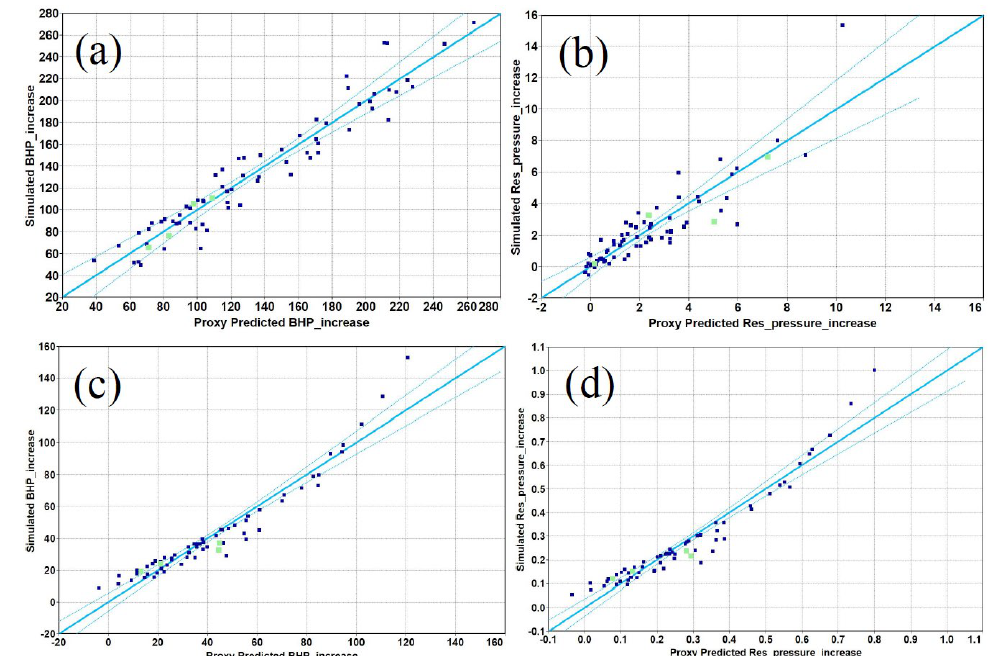
Figure 10. Simulated values versus the values predicted by the proxy model. Blue and green dots indicate training and verification runs, respectively, and dotted lines represent the 95% confidence interval around the regression model for ( a ) bottomhole pressure buildup for supercritical CO 2 injection, ( b ) average reservoir pressure buildup for supercritical CO 2 injection, ( c ) bottomhole pressure buildup for low-salinity water injection, and ( d ) average reservoir pressure buildup for low-salinity water injection. Factors identified as important were used to create the proxy statistical model. A simple quadratic regression was used to connect these parameters to the response. Equations (2) and (3) are the proxy equations for pressure buildup in the wellbore and reservoir, respectively, due to CO 2 injection (units are as indicated in Table 1 and abbreviations are indicated in